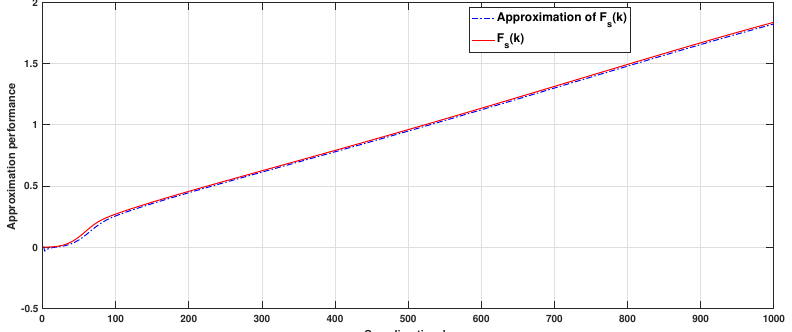
Figure 2. DoS attack sequence for the 100th iteration.